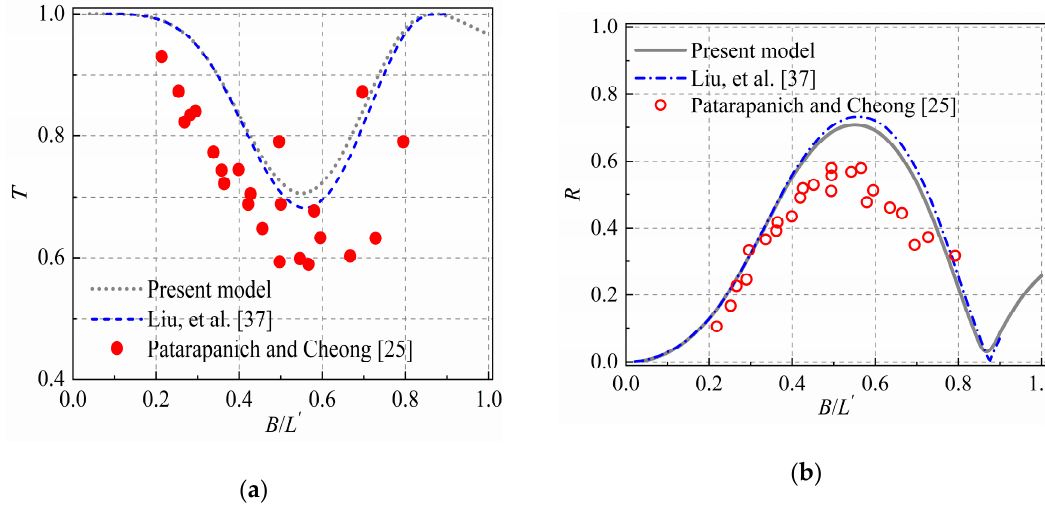
Figure 4. Comparison between the present method and the existing results [37,25] of thin plate: ( a ) ( a ) Transmission; ( b ) Transmission; ( b ) Reflection.